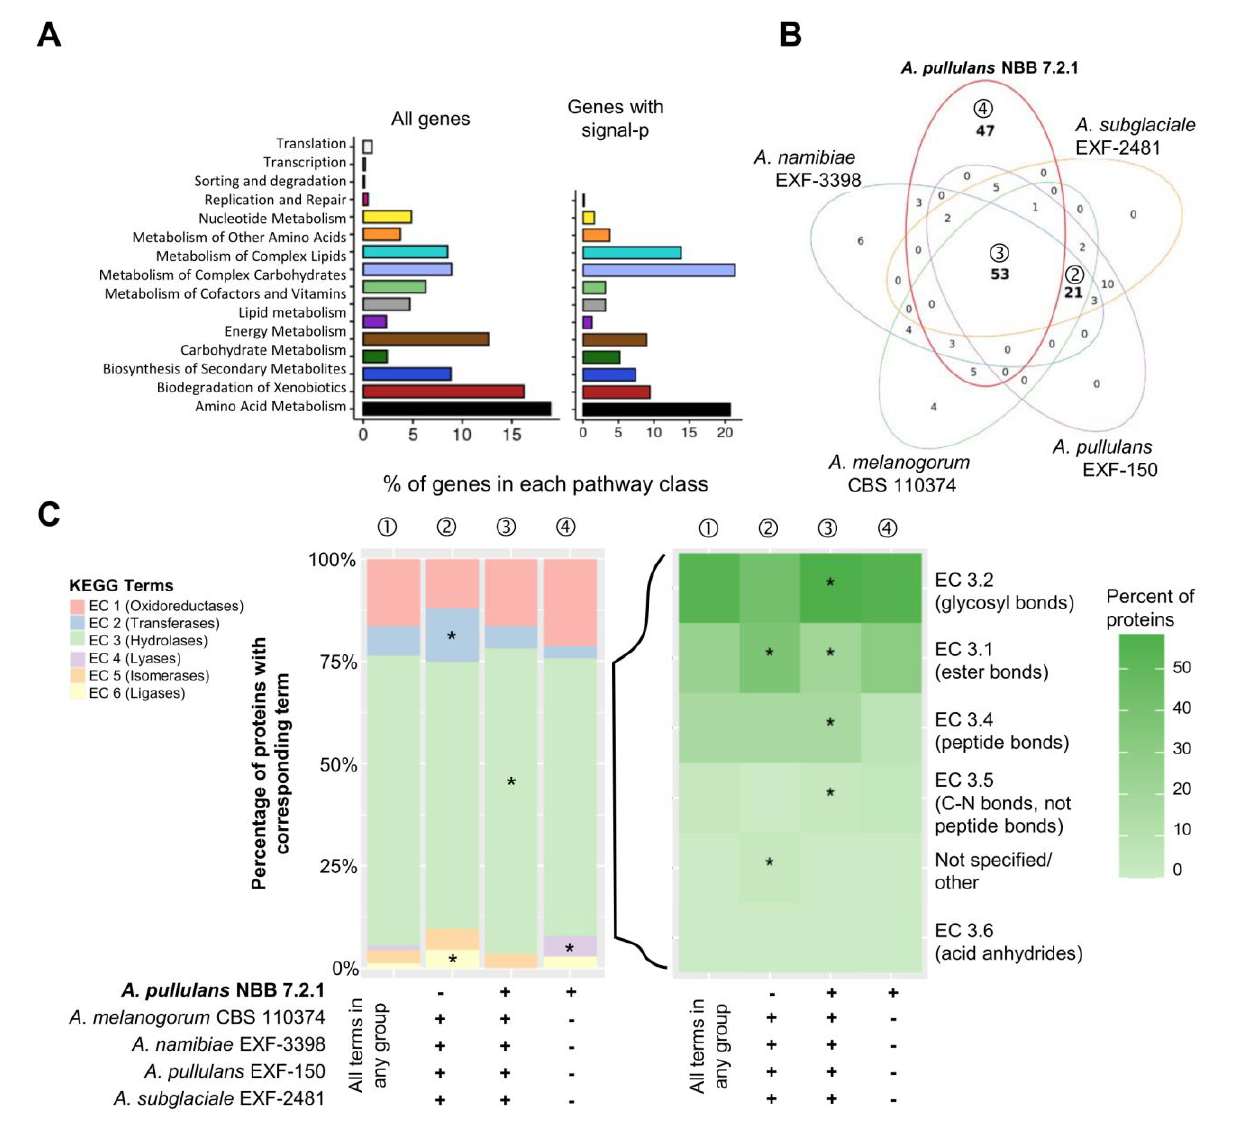
FIGURE 3 : Genome mining of Aureobasidium genomes to identify potential biocontrol genes. Functional annotations of the five Aureobasid- ium genomes (obtained from the DOE-JGI MycoCosm) identified a plethora of genes and gene clusters that may contribute to biocontrol activity. (A) Relative percentage of A. pullulans NBB 7.2.1 genes (for the 4019 genes with a KEGG annotation or only the subset containing a predicted signal peptide) assigned to the different KEGG pathways. (B) KEGG term distribution among the five Aureobasidium genomes for all annotated genes containing a predicted signal peptide. 53 terms were commonly found in all species (  ), while 47 terms were unique for the A. pullulans NBB 7.2.1 genome (  ) and 21 were exclusively found in the other genomes (  ) (bold numbers in Venn diagram). (C) The relative percentage of genes with a predicted signal peptide annotated to belong to one of the six main enzyme classes (EC 1-6; oxidoreductases, transferases, hydrolases, lyases, isomerases, ligases). Results are shown for genes with terms that were found in any of the five genomes (  ) and for those shared in all genomes except A. pullulans NBB 7.2.1 (  ), shared among all five genomes (  ), or only present in A. pullulans NBB 7.2.1 (  ). The enzyme classes highlighted with an asterisk were significantly overrepresented (adj. p- value≤0.05) in the respective group. Among the predicted hydrolase genes with a signal peptide, esterases (EC 3.1), glycosylases (EC 3.2), and peptidases (EC 3.4) were by far the most frequent and significantly overrepresented in genes with terms shared by all five Aureobasidium OPEN ACCESS | www.microbialcell.com